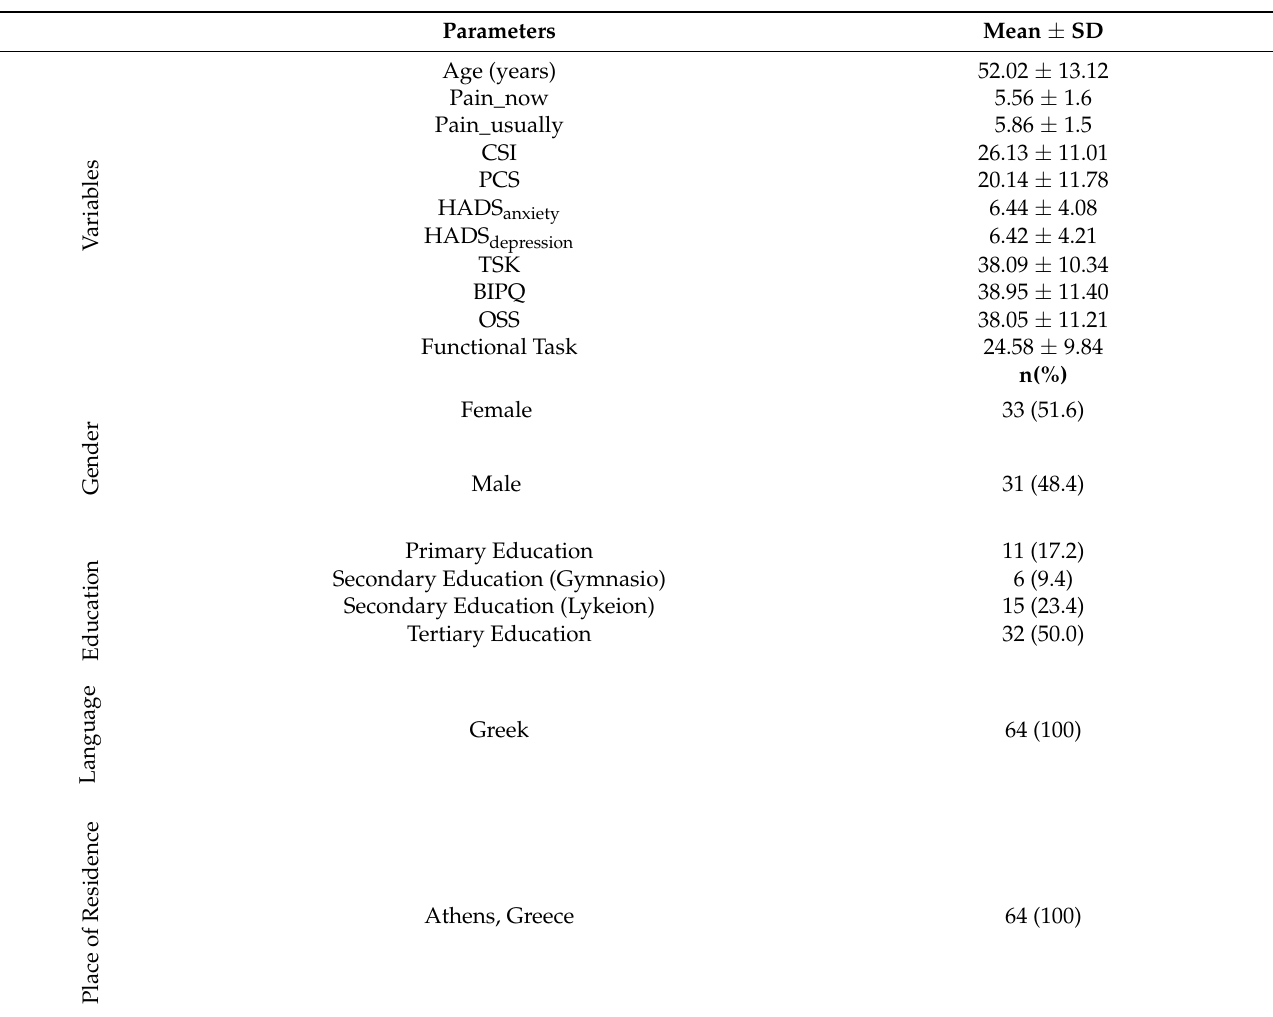
Table 1. Descriptive statistics of the study ( N =